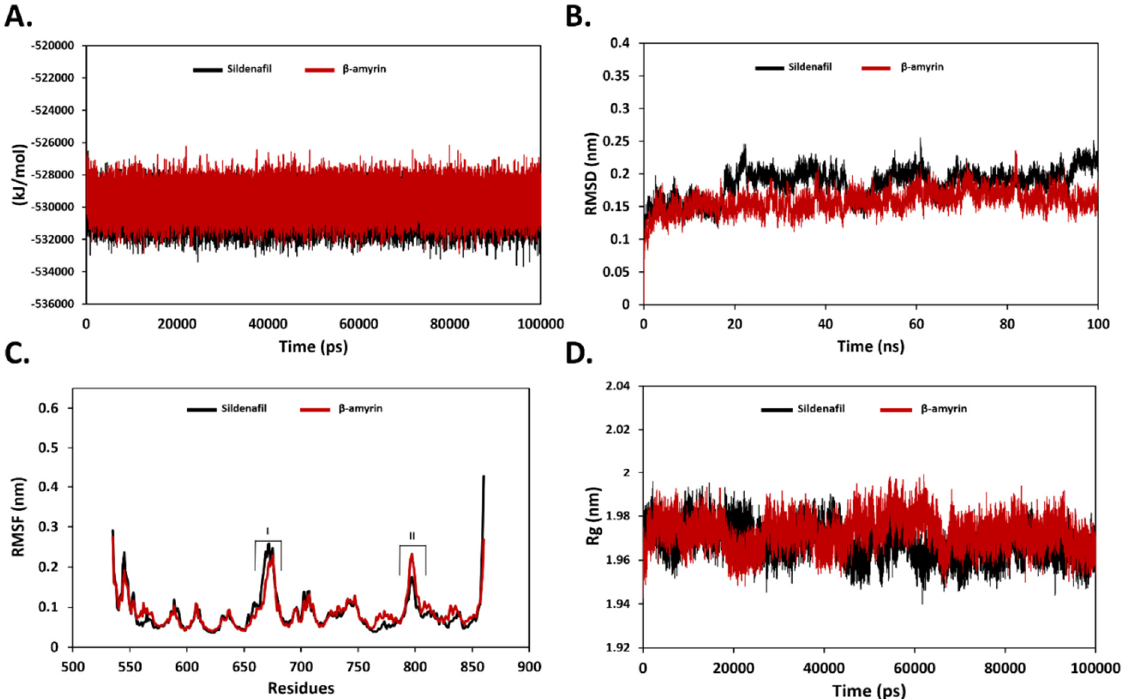
Figure 3. MD simulation plots for checking the overall stability of the systems during 100 ns. ( A ) Potential energy profile of PDE5 in the presence of sildenafil and β -amyrin. ( B ) RMSD profile of PDE5 in the presence of sildenafil and β -amyrin. ( C ) RMSF of simulated complexes of PDE5 with sildenafil and β -amyrin. ( D ) Radius of gyration of PDE5 with bound sildenafil and β -amyrin. The figure was drawn using Microsoft Excel 2016.